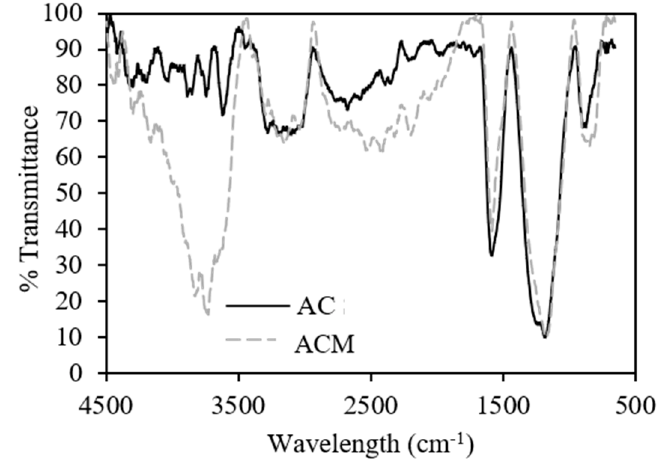
Figure 7. FTIR of the synthesized and modified activated carbon. The continuous line indicates the FTIR for the synthesized activated carbon (AC) material, whereas the dotted line refers to the FTIR for the activated carbon modified with 5.0 wt.% of magnetite nanoparticles (ACM) material.